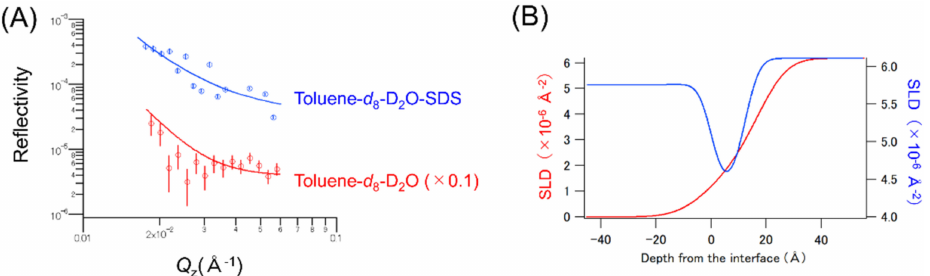
Figure 4. ( A ) NR profiles obtained from the toluene- d 8 -D 2 O and toluene- d 8 -D 2 O-SDS samples. The NR profiles of the toluene- d 8 -D 2 O sample are vertically shifted to show the NR profiles more clearly. ( B ) The SLD profiles of the air-D 2 O-SDS and toluene- d 8 -D 2 O-SDS samples. The fitting curves and the SLD profiles of the air-D 2 O-SDS sample obtained by different models (Tables S3 and S5) are given in Figure